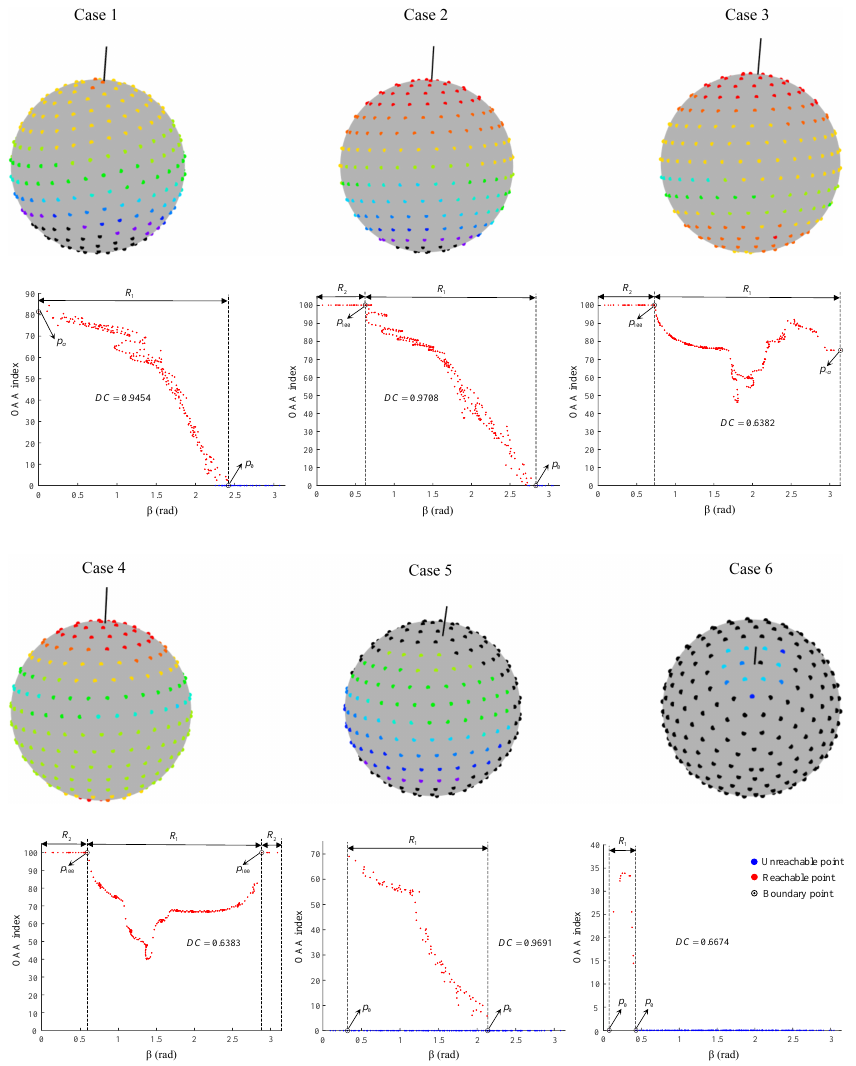
Figure 14. The distributions of the OAA index for five typical reachability spheres and the distribu- tions of their corresponding sample points, where DC represents the distance correlation coefficient of each two-dimensional sample point